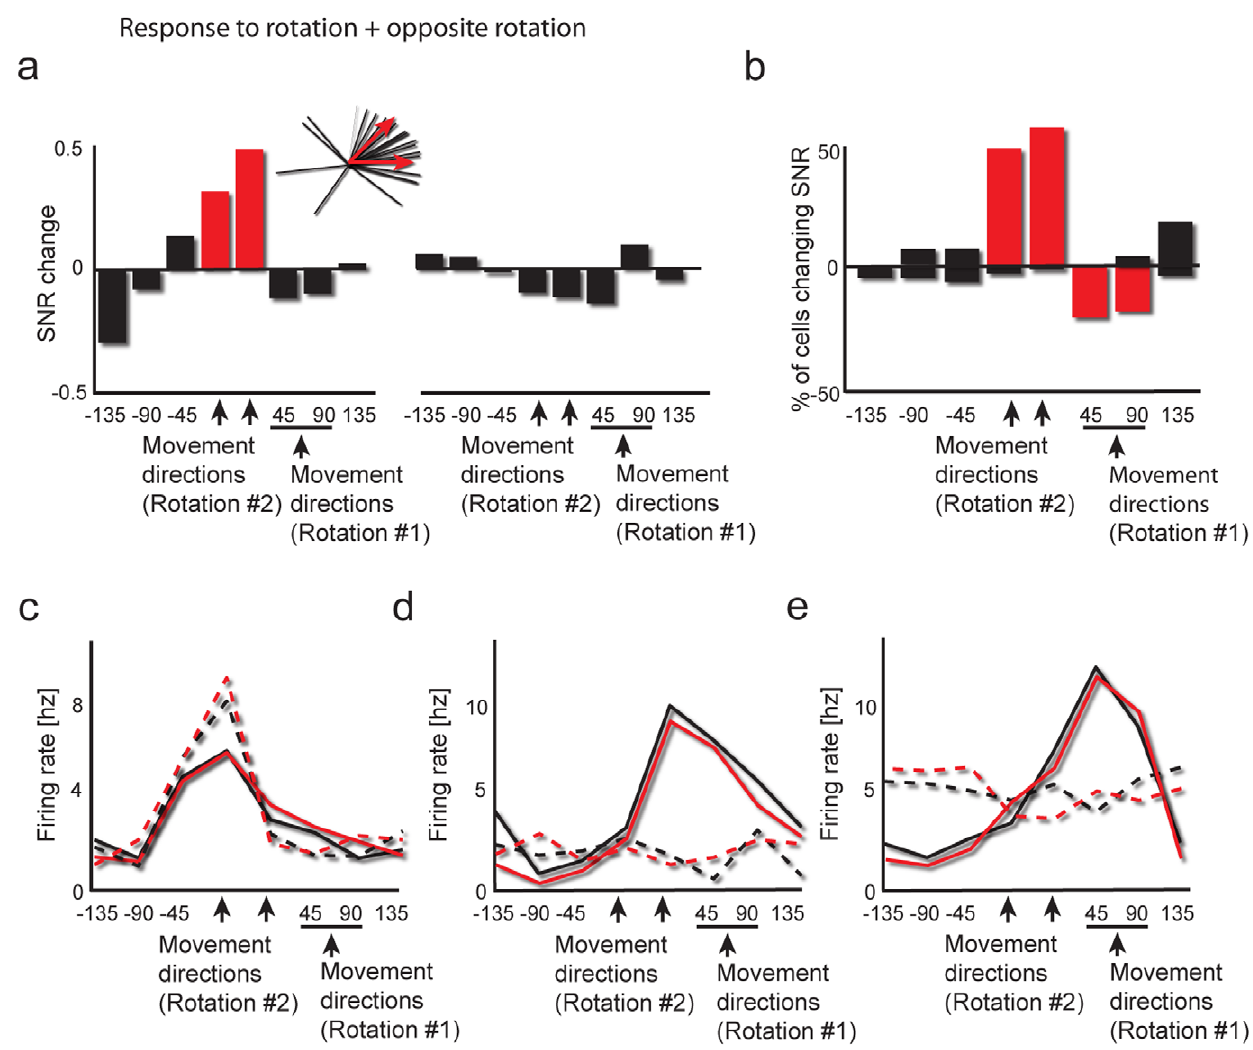
Figure 6. The lack of simultaneous representation after learning rotation followed by opposing rotation. (a) SNR changes for rotation followed by opposite rotation tasks (n=140 cells). Notation same as Figure 2c. Note that SNR elevation is restricted to the directions used during the second rotation. (b) Percentage of neurons significantly increasing or decreasing their SNR after learning (during the TO epoch). Red marks directions where a significant portion of the neurons changed their SNR. (c–e) Examples of single neurons, notation same as Figure 4. (c) Neuron with a pre- learning PD that was close to the directions used during the second rotation. (d–e) Two neurons whose pre-learning PDs were close to the directions used during the first rotations.